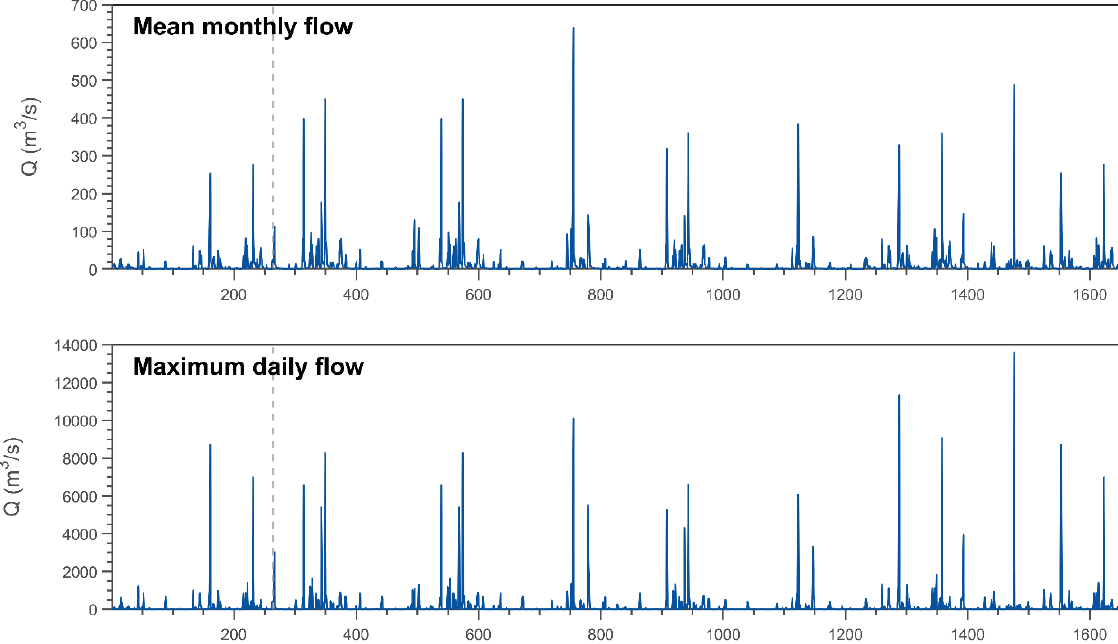
Figure A8. Mean monthly (top) and maximum daily (bottom) synthetic inflow hydrographs of additional scenario #6. The dashed line indicates the construction of the Wivenhoe